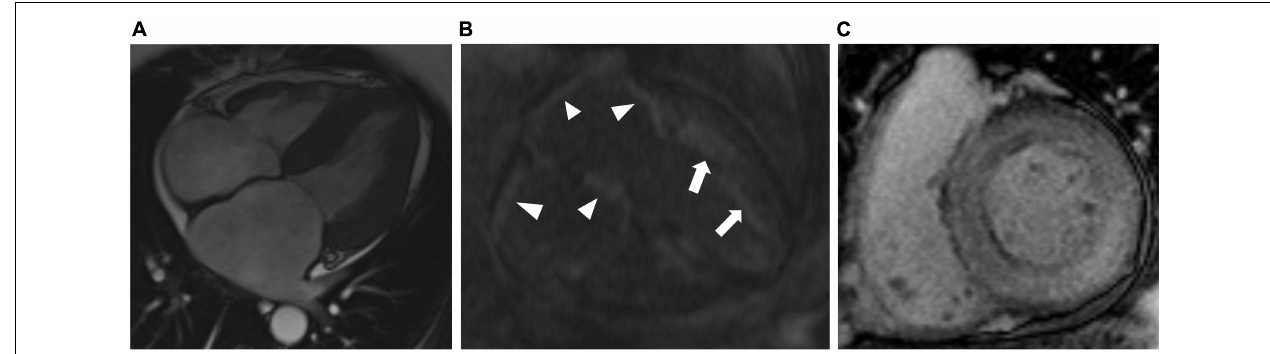
FIGURE 5 | Representative cardiac magnetic resonance images (CMR) from patients with cardiac amyloidosis. (A) T2 TRUFI 4-chamber view showing biventricular hypertrophy, biatrial enlargement, and pericardial effusion. (B) T1 4-chamber view late post-contrast image in a patient with ATTR-CA showing diffuse atrial LGE (arrowheads) and left ventricular subendocardial LGE (arrows). (C) T1 short-axis late post-contrast image in a patient with AL-CA showing diffuse LGE of the left